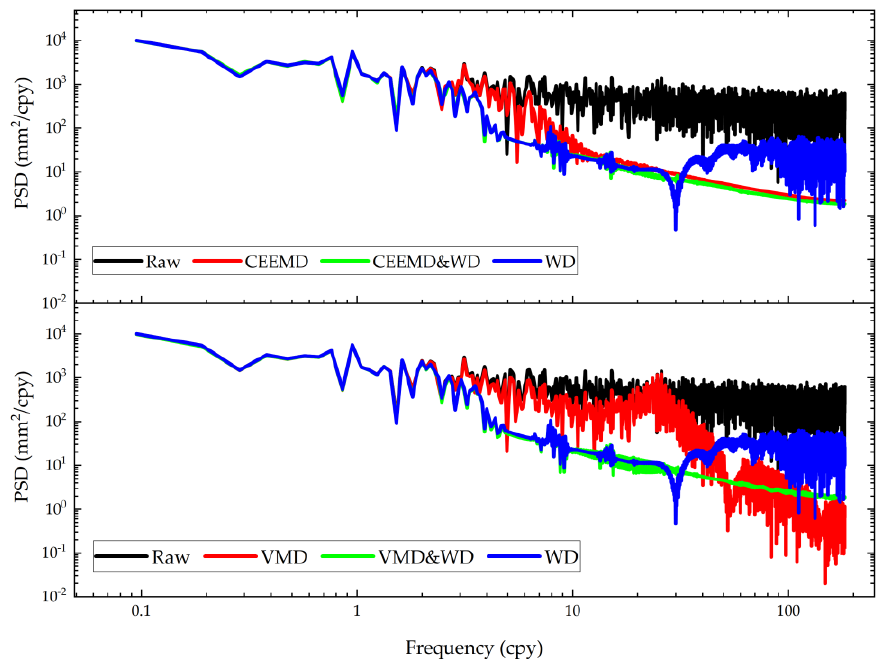
Figure 9. The power spectral density (PSD) of residual vertical coordinate time series after applying different methods for BJSH station.